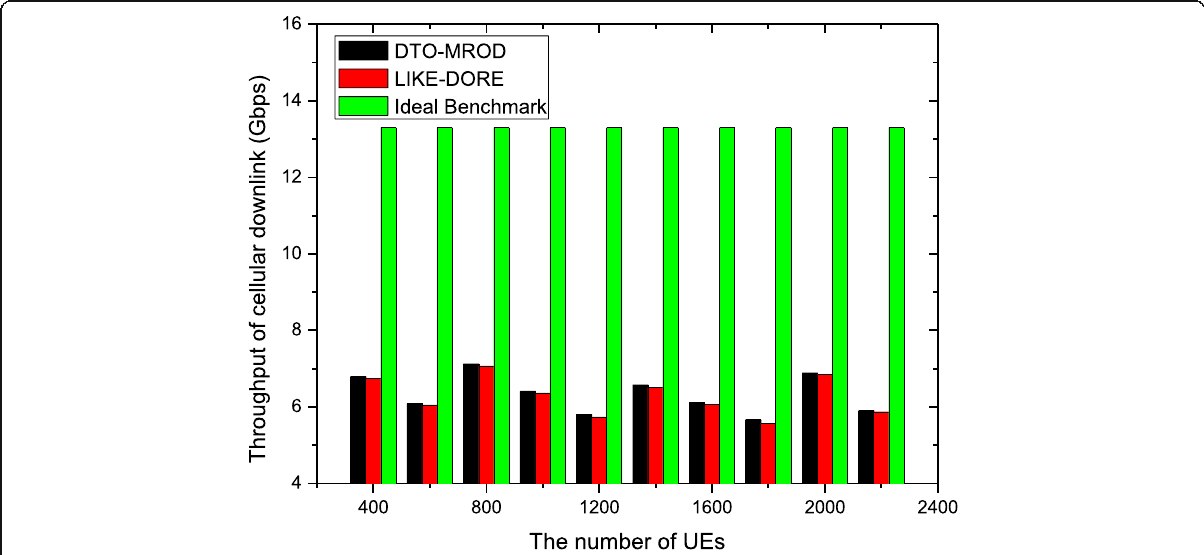
Fig. 4 Throughput of cellular downlink for the two schemes and ideal benchmark under the different numbers of UEs